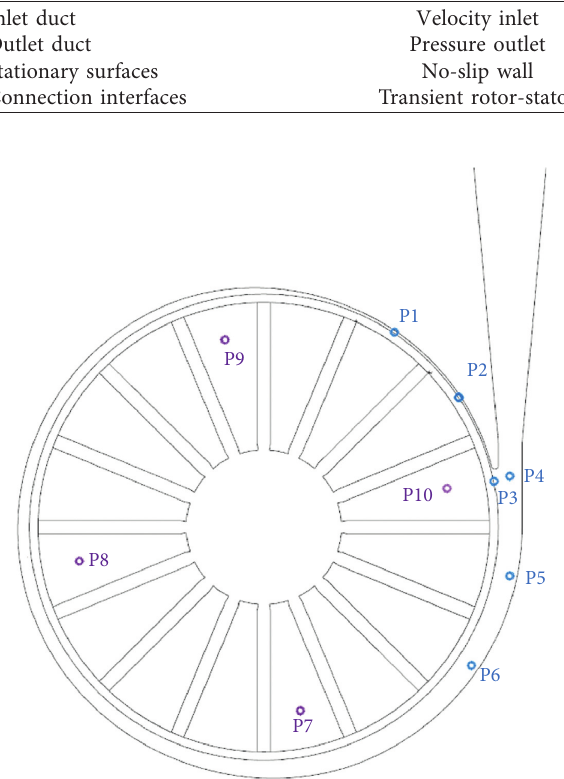
Figure 4: Comparison of experiment and simulation.